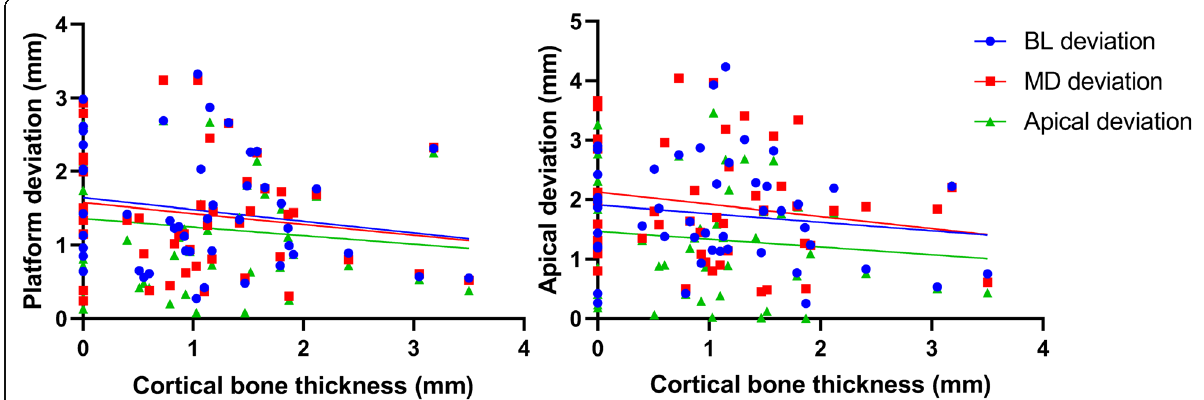
Fig. 7 Scatter plot showing a linear correlation between cortical bone thickness and implant deviation. Left: deviation at the implant platform; right: deviation at the implant